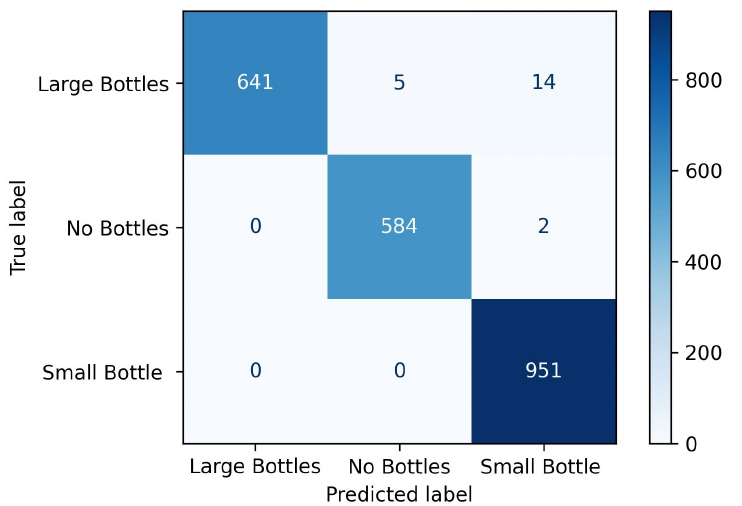
Figure 9. Confusion matrix for test data. Table 2. Precision and accuracy for each class.